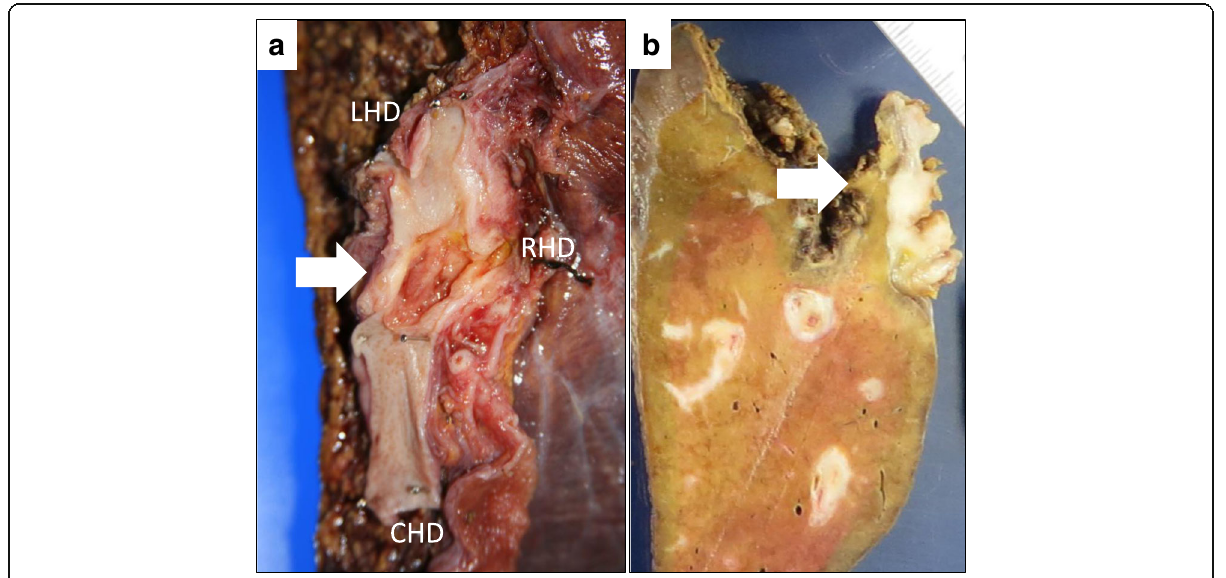
Fig. 5 Macroscopic findings. A 33 × 15-mm well-demarcated tumor occupied the bile duct at the hepatic hilum (arrow). a Gross examination of the resected specimen. b Cut surface of the hepatic hilum. CHD common hepatic duct. RHD right hepatic duct. LHD left hepatic